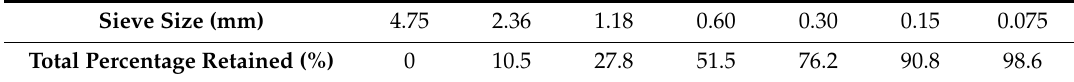
Table 2. The gradation compositions of the fine aggregate.